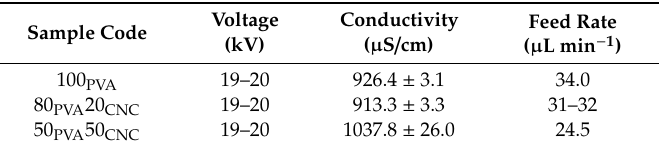
Table 2. Average fiber diameter (nm) with standard deviation, minimum and maximum values by electrospun mat composition. The electrospun mats with heat treatment are labeled (H). Fiber Diameter (µm) Sample